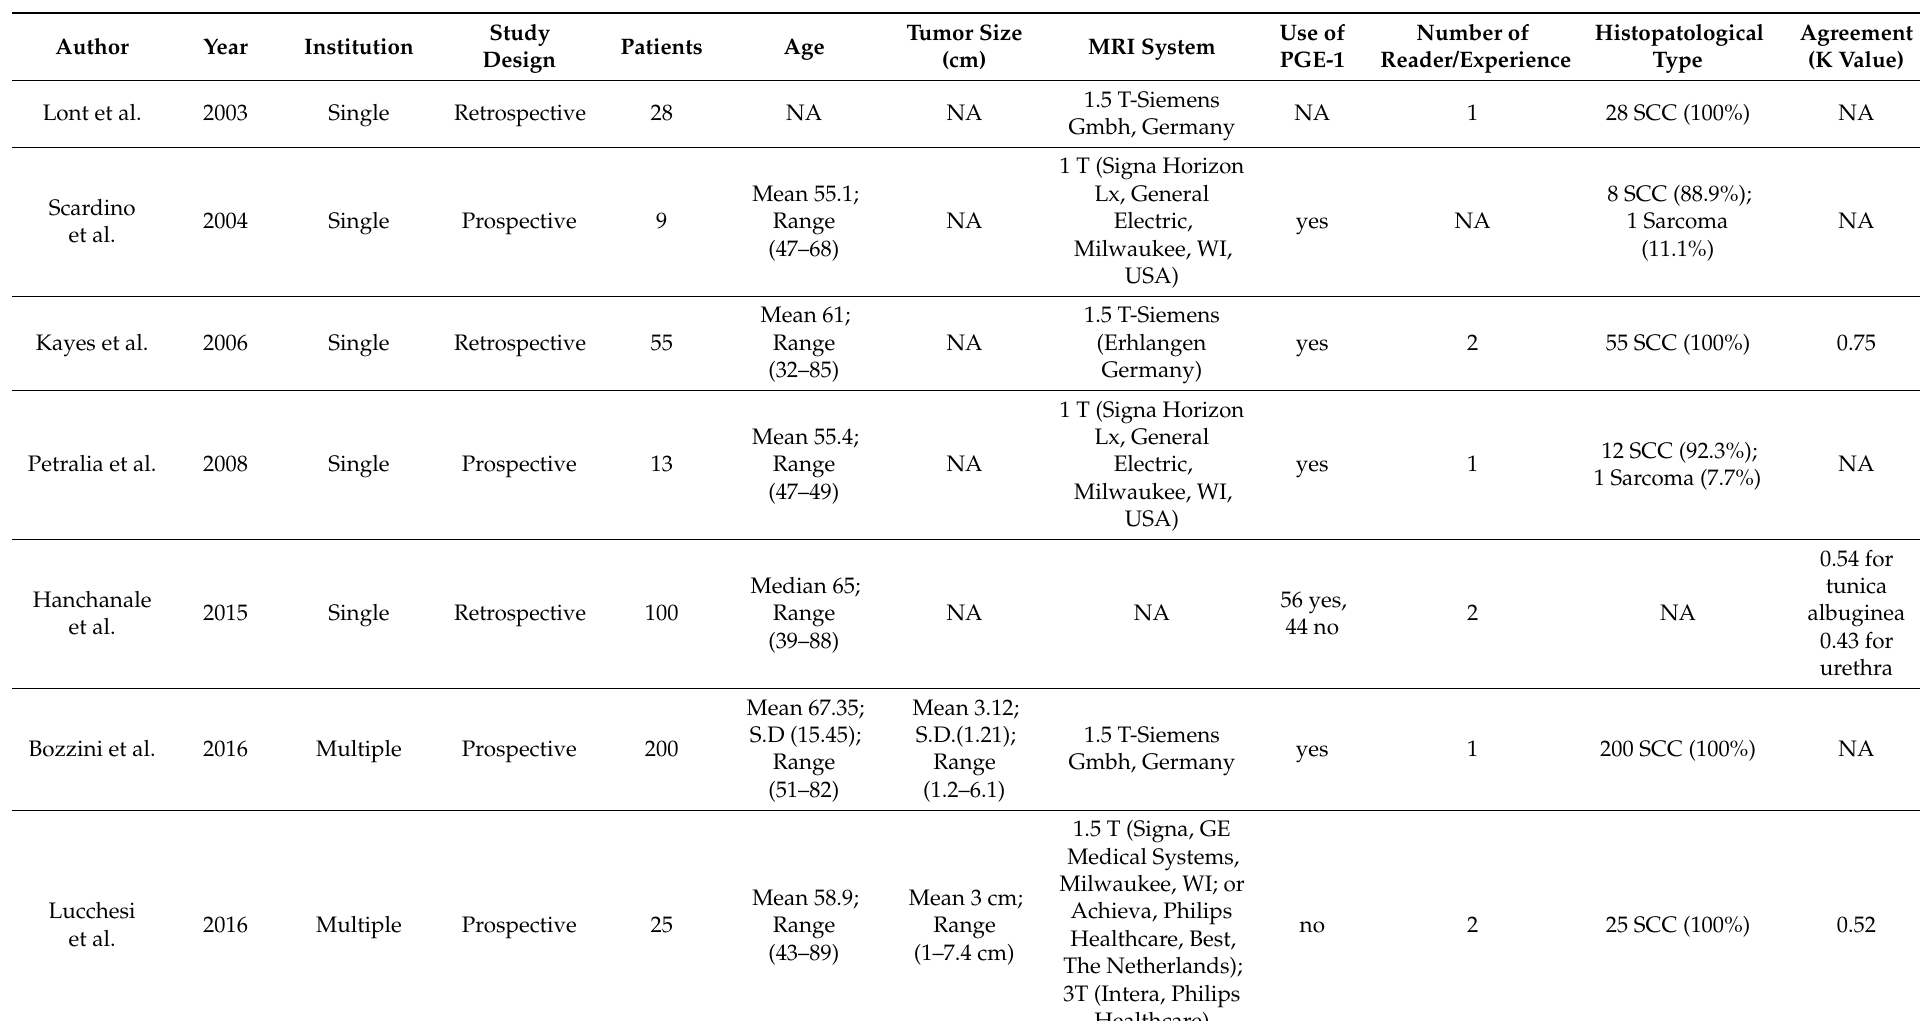
Table 1. Summary of published research: Baseline characteristics among eligible studies testing the diagnostic performance of preoperative magnetic resonance imaging. Author Lont et